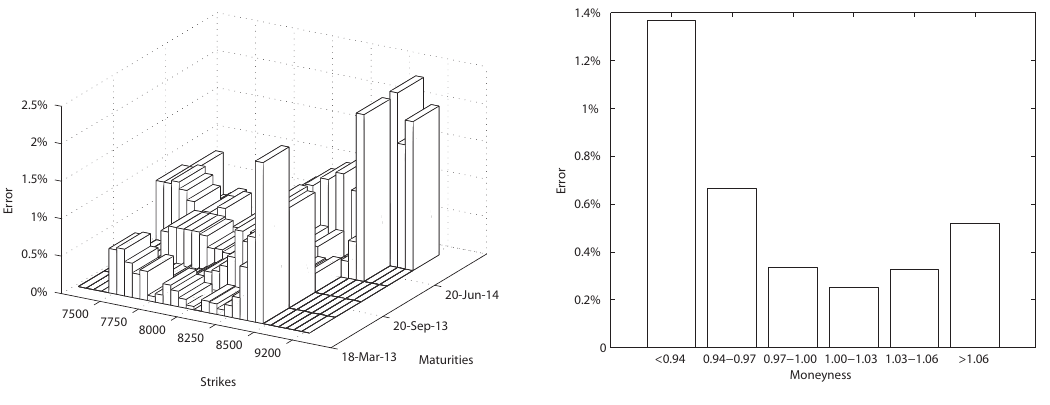
Fig. 6. Results for lsqnonlin . The left picture portrays the absolute relative errors. The right picture shows the average absolute relative errors in terms of moneyness. The initial point was provided by